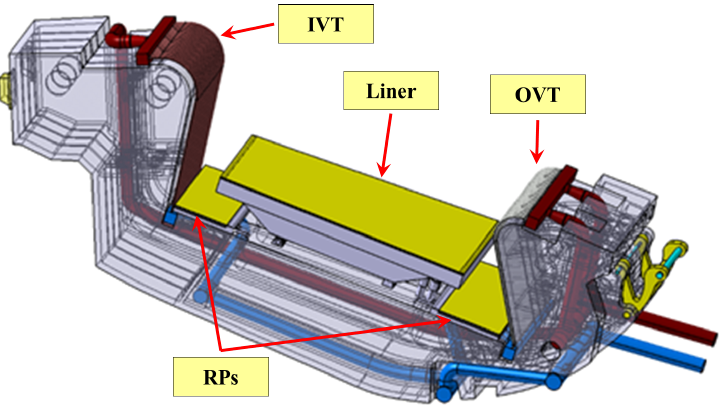
Figure 1. The DEMO divertor